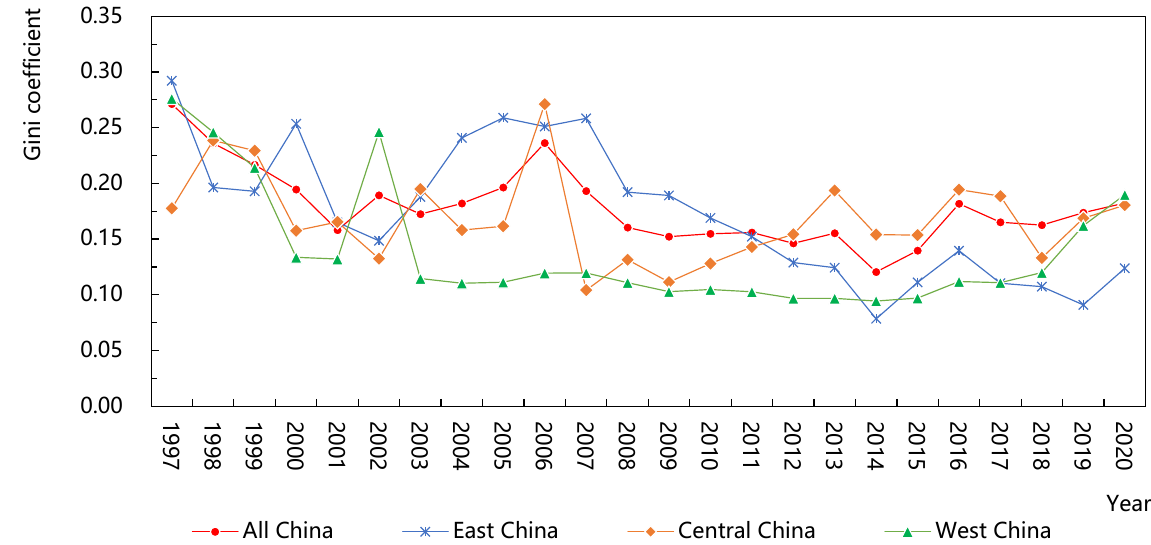
Figure 3. Changes in Dagum Gini coefficient in China and its regions.